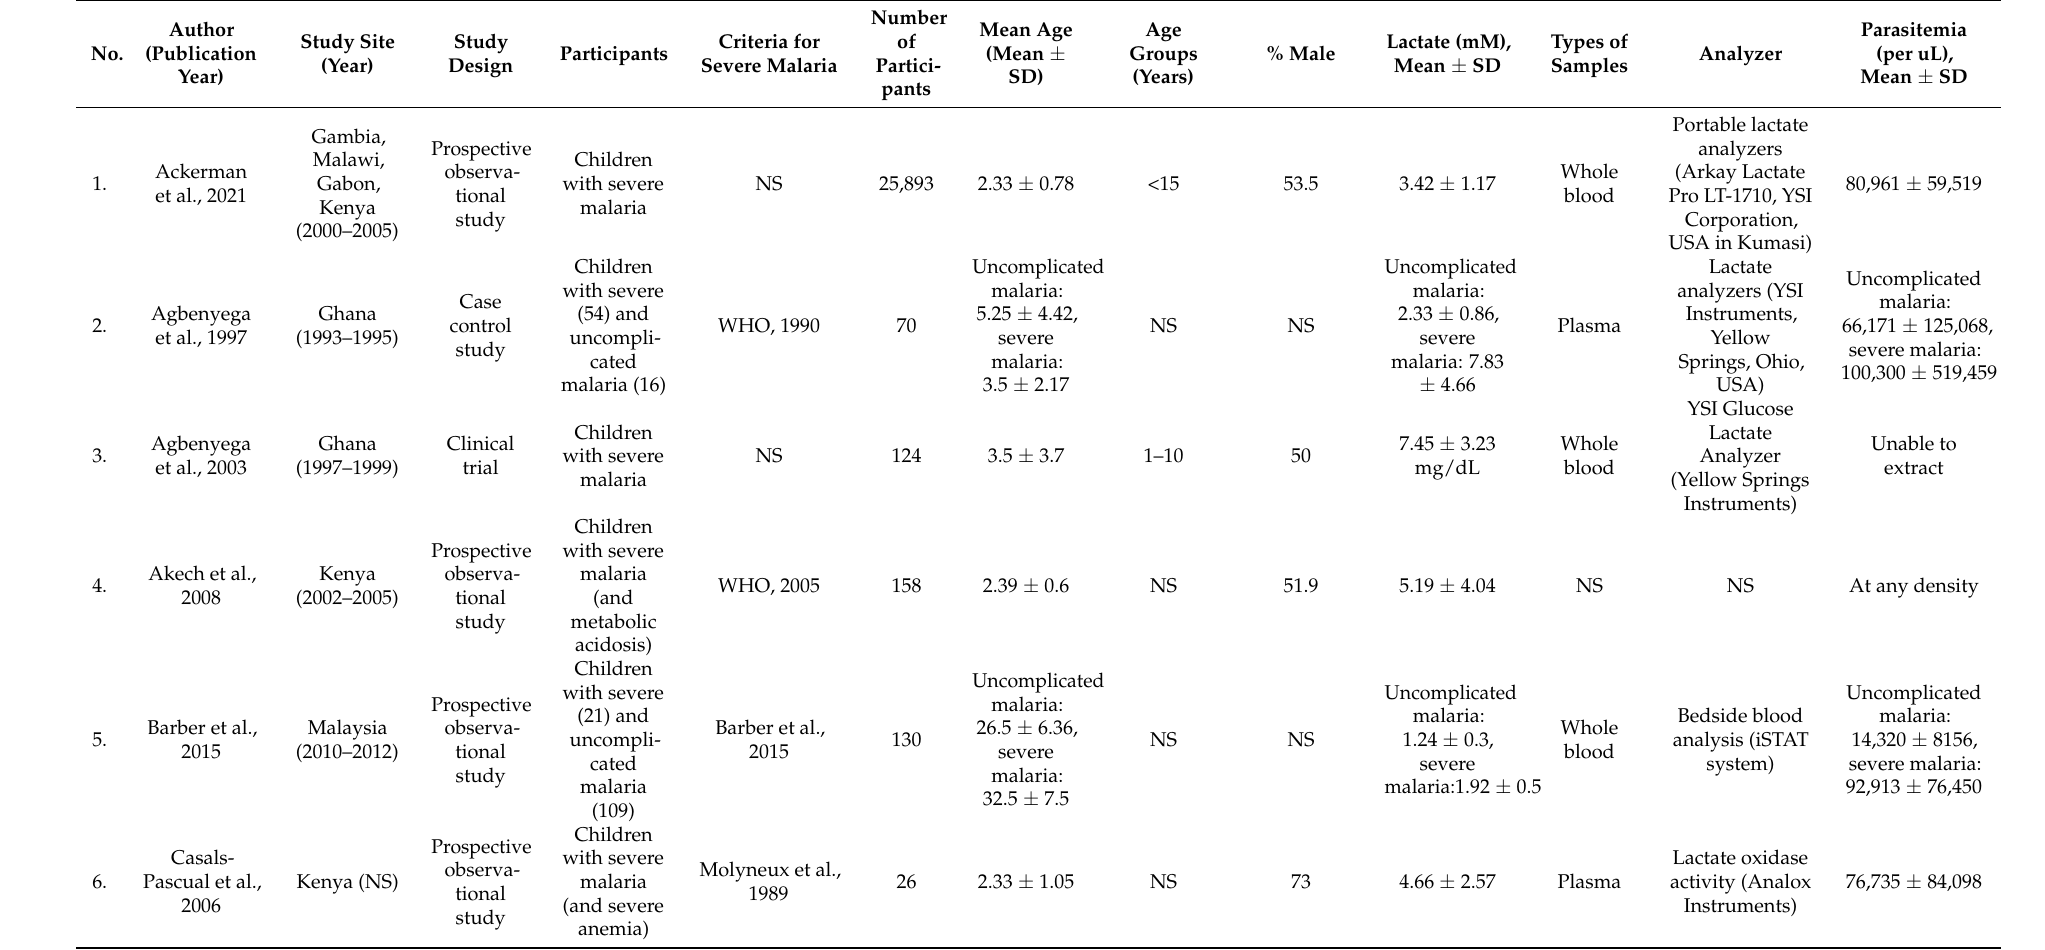
Table 1. Characteristics of the included